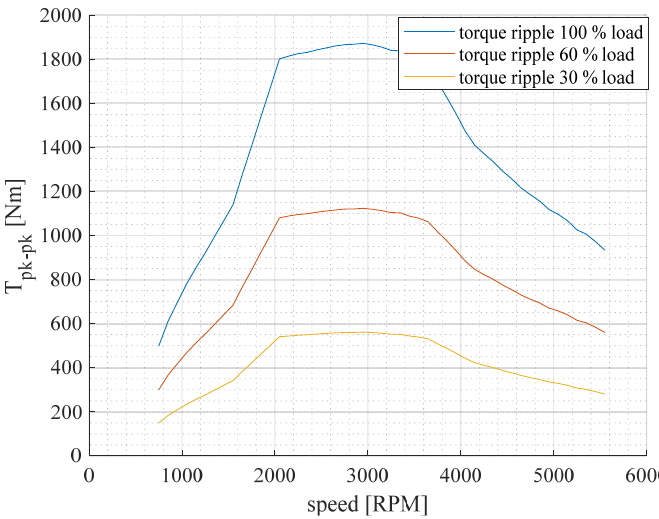
Figure 2. Mapping oscillating torque depending on rotating speed and loading 100–60–30% without damper.